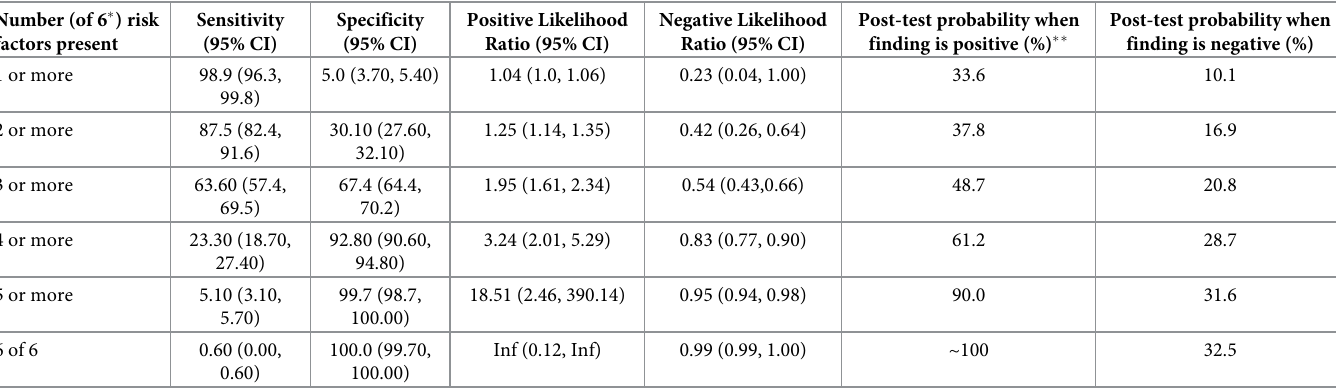
Table 4. Clinical prediction tool for postpartum running-related pain based on having different numbers of risk factors and current pain with running. Number (of 6 � ) risk factors